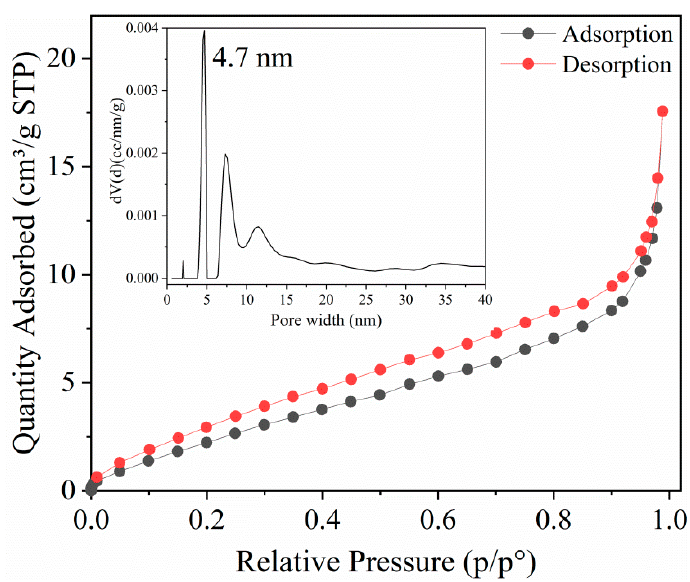
Figure 2. N 2 adsorption-desorption isotherms of MOF 1 . (Inset is pore size distribution).